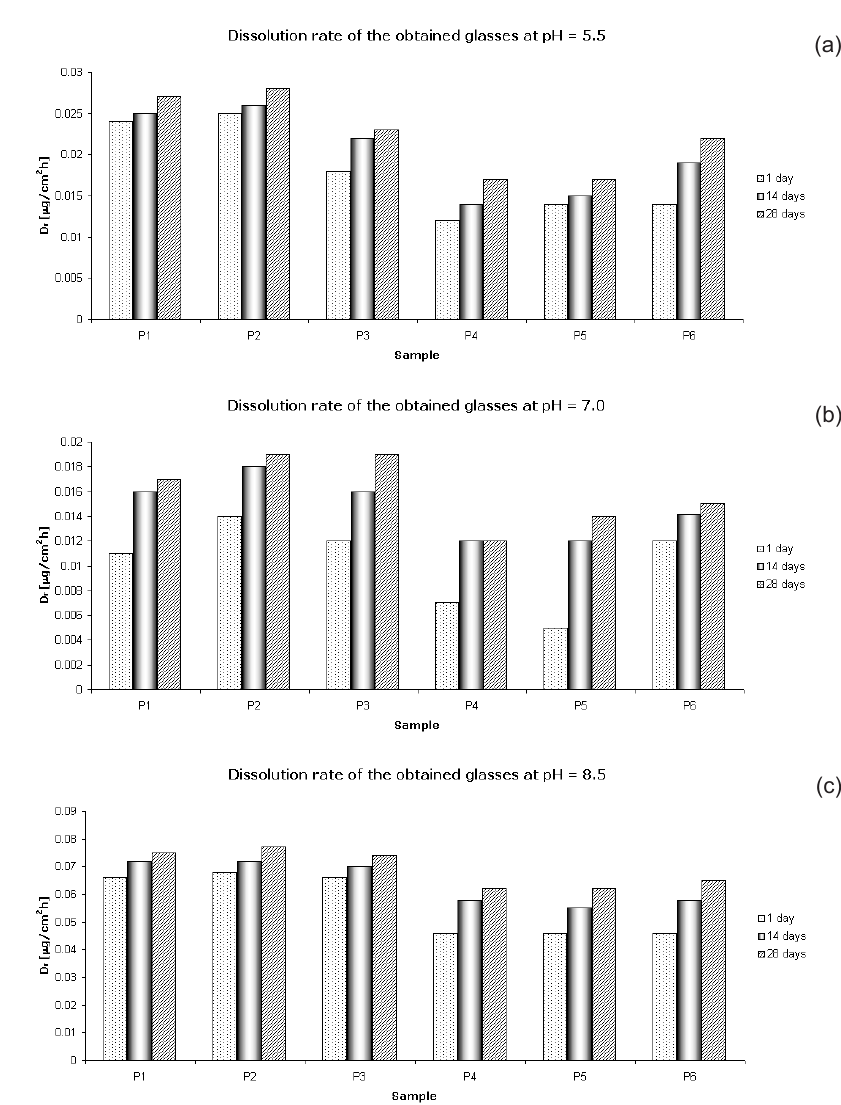
Figure 2. Chemical stability of the